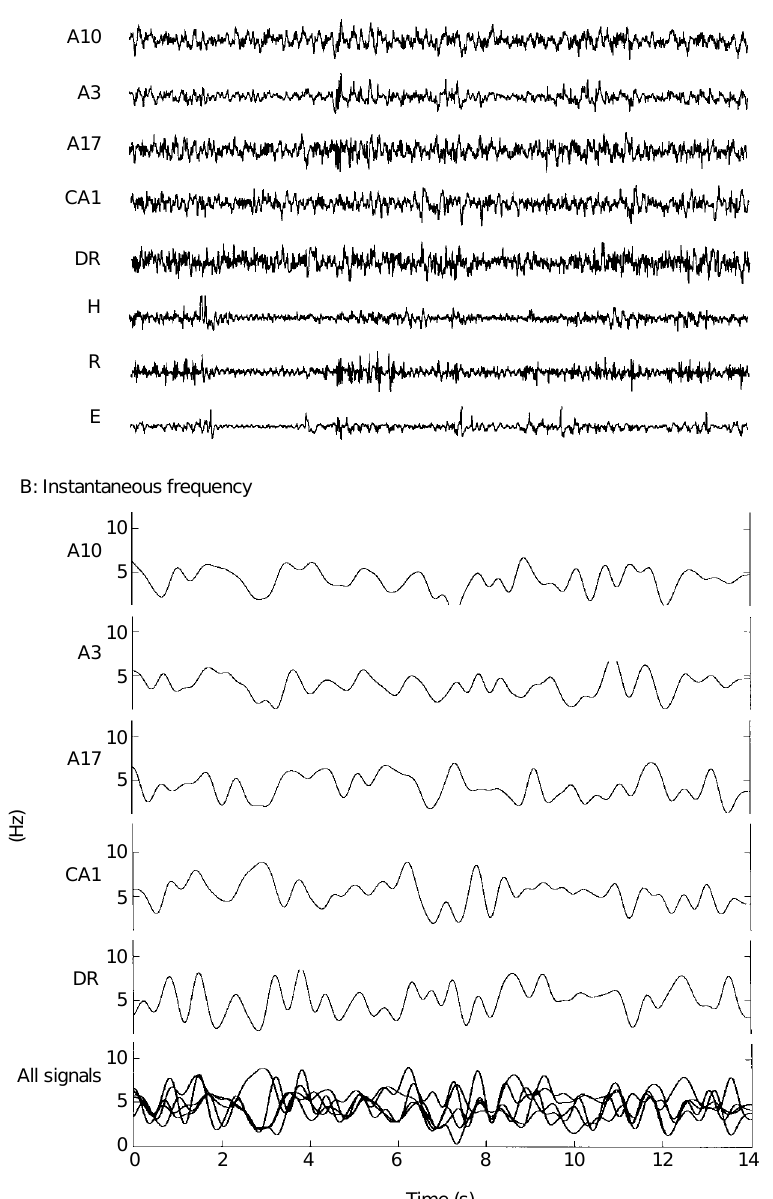
Figure 2 - A , Electro-oscillograms as in Figure 1A, after 8-OH-DPAT administration. The rat moved more intensely 20 to 30 s after microinjection, as shown by the larger number of high voltage muscle potentials. Despite the increase in spontaneous movements, no organized behavior can be identified. The electro-oscillograms display low entropy signals, but desynchronization is predominant and theta rhythm is not prominent and appears not to be rhythmically well organized. B , Instantaneous frequency variation. Only CA1, which receives its major serotoninergic afferentation from the median raphe nucleus, shows a trend to narrowing the oscillation band (segments 4 to 6 and 8 to 11 s). DR, however, oscillates more regularly (at 1 to 1.5 Hz). Abbreviations as in legend to Figure